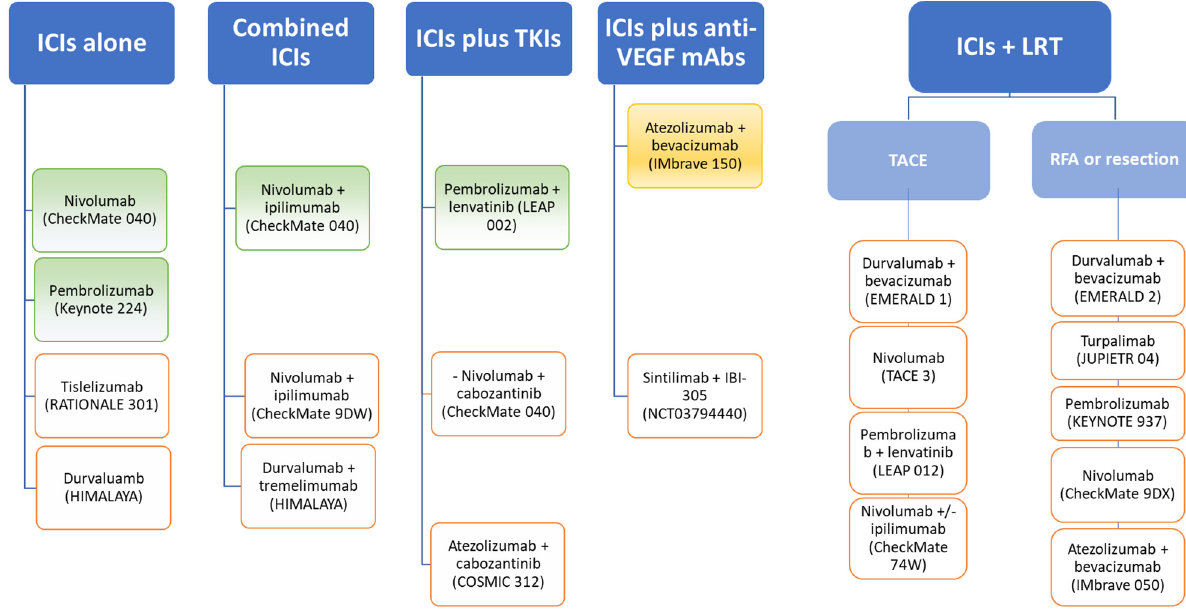
Figure 1. Possible HCC treatments with ICIs. Atezolizumab plus bevacizumab has been approved as a first-line treatment, whereas nivolumab with or without ipilimumab and pembrolizumab gained FDA approval as second-line treatments. Selected Phase III trials (orange squares) are testing ICIs alone or in combination or combined with other agents in the first and second-line setting, and in the adjuvant and neo-adjuvant setting as well.